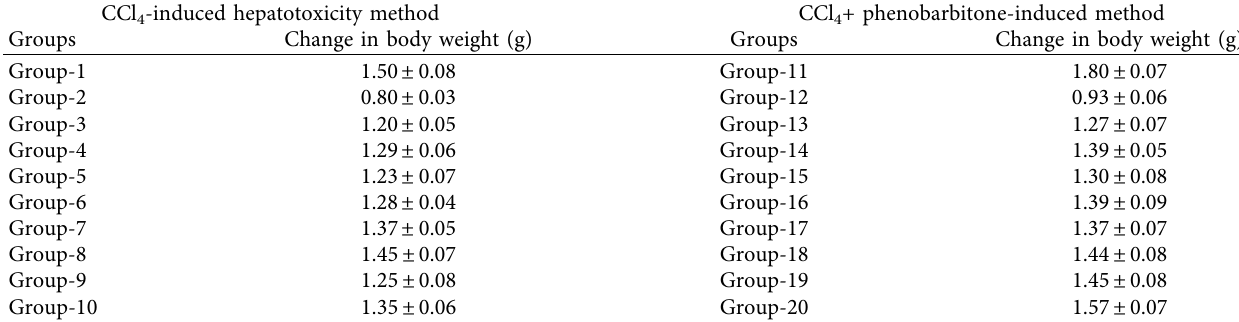
Table 4: Effect of Polyherbal formulations on the gain of body weight.